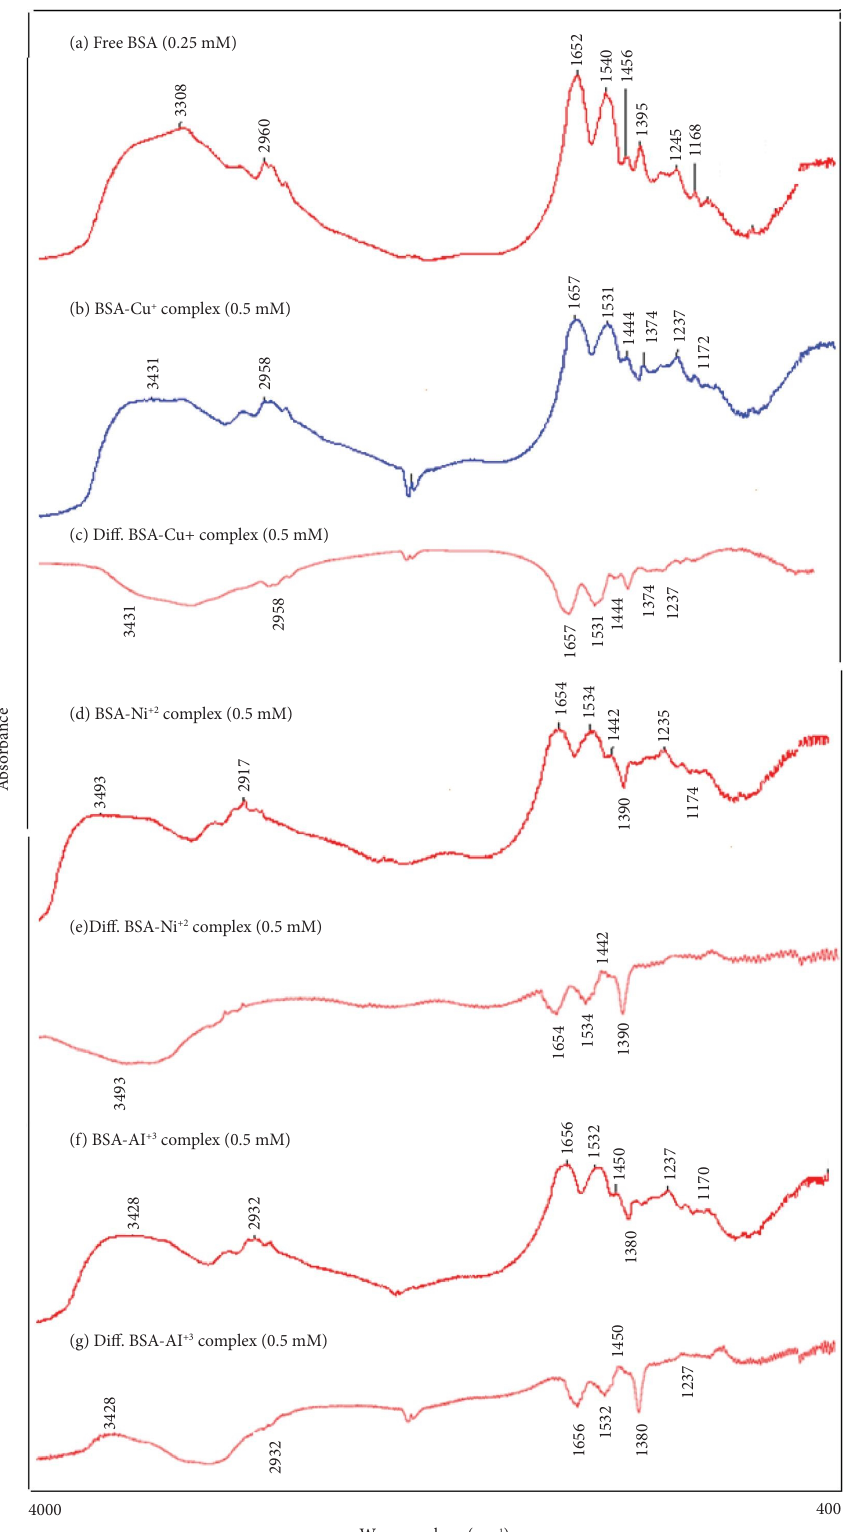
Figure 2: Fourier transform IR spectra of (a) unbound BSA, (b) BSA-Cu complex (0.5mM), (c) diferential complex of BSA-Cu (0.5mM), (d) complex of BSA-Ni (0.5mM), (e) diferential complex of BSA-Ni (0.5mM), (f) complex of BSA-Al (0.5mM), and (g) diferential complex of BSA-Al